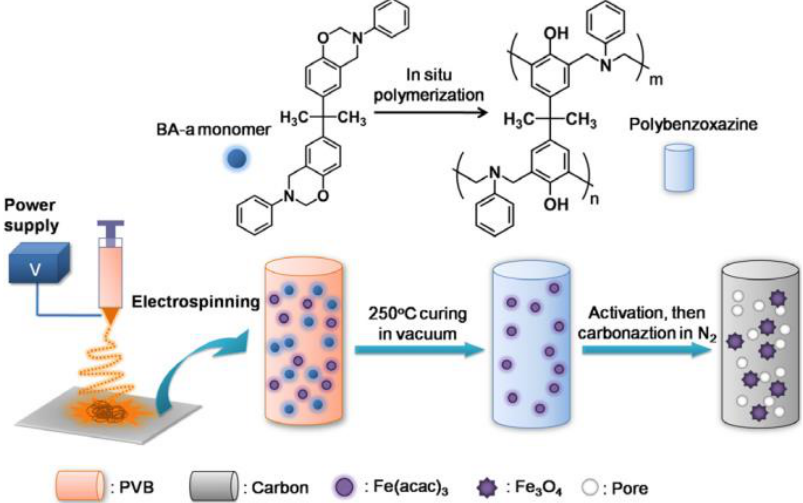
Figure 16. Formation of A-Fe@CNF through BA-a polymerization, electrospinning, curing, activation, and carbonization (reproduced from the work in [39] with permission).